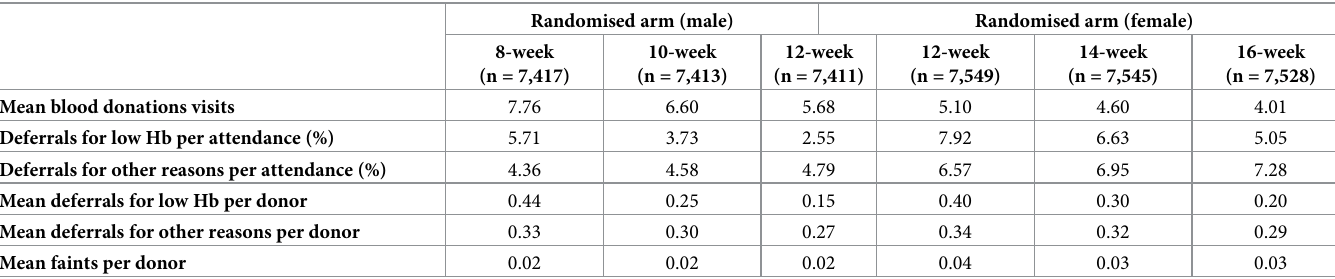
Table 2. Resource use over two-year follow-up period, by randomised arm and